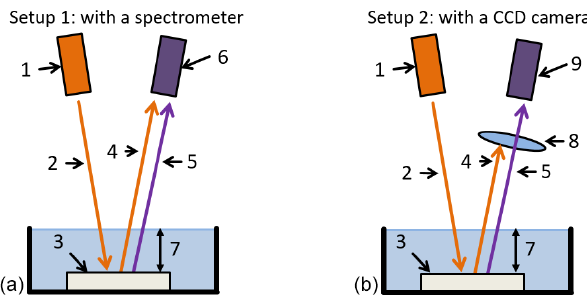
Figure 1. Schematic representation of the extended theoretical model for ( a ) the identification (Setup 1) and ( b ) the imaging de- tection (Setup 2) of plastics in water, with the light source (denoted by 1), the incident photons (2), the polymer sample (3), the reflected light (4), the fluorescent light (5), a wavelength-dependent detection unit (6), the height of the water (7), an edge filter (8) and an imaging device